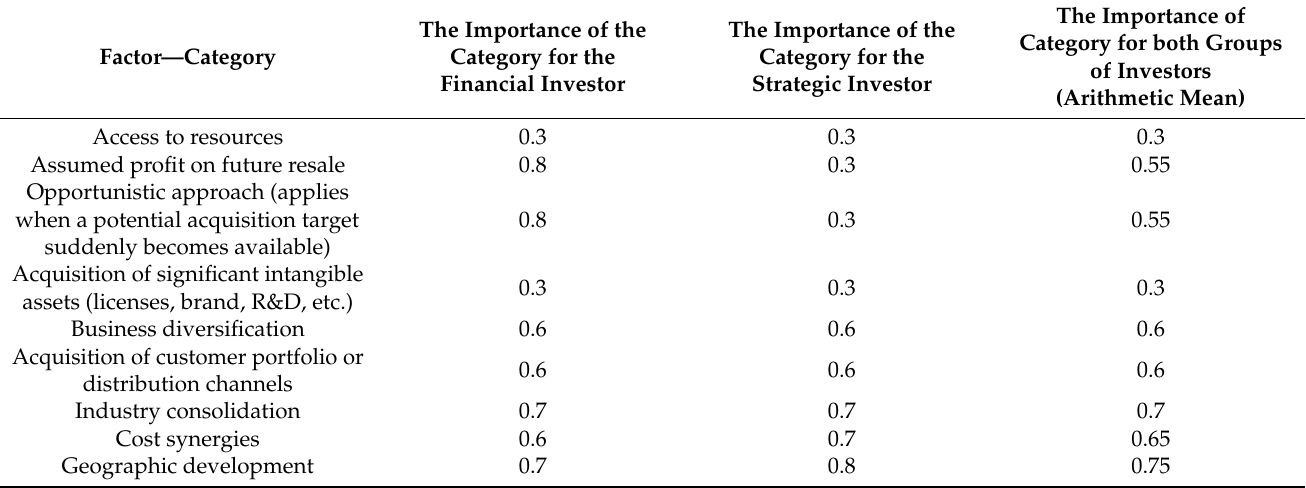
Table 7. Distance between investment motives in mergers and acquisitions undertaken by financial and strategic